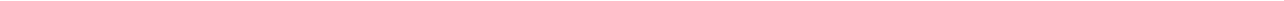
Fig. 1 Characterization of Plzf-mC/CreER transgenic mice. a , b Representative IF of adult Plzf-mC/CreER testis sections ( n = 3 mice). Tubule stages and populations are indicated. Scale bar, 50 μ m. c Representative fl ow cytometry of fi xed and permeabilized testis from Plzf-mC/CreER and wildtype (WT) adult testis ( n = 3 mice per genotype). PLZF + cells are shown. d Plzf-mC/CreER; Z/EG mice injected daily with TAM for 5 days were harvested at indicated days after treatment. e Representative IF of testis sections from d ( n = 3 testes per time point). Insets show details of indicated areas. Scale bar, 50 μ m. f Representative whole-mount IF from d . Inset shows detail of indicated area. Arrowheads: unlabelled GFR α 1 + cells. Scale bar, 50 μ m. g Flow cytometry of fi xed and permeabilized testis cells from d . Graph indicates mean fraction of A undiff (PLZF + c-KIT − ) and PLZF + c-KIT + early differentiating cells expressing GFP ± standard error of mean (s.e.m.) ( n = 4 testes D3, D10 and D90, n = 6 testes D30). h Representative fl ow cytometry of live Plzf-mC/ CreER testis cells. SSC is side scatter. mCherry + gate was set according to WT. i Quantitative RT-PCR for spermatogonial markers from Plzf-mC/CreER cell fractions sorted as in h . mC − indicates mCherry − . Expression levels are corrected to β -actin and normalized so mean value of fraction #2 equals 1. Mean values± s.e.m. are indicated ( n = 3 sorts, 2 mice pooled per sort). Signi fi cance vs. mCherry − cells is shown. j Violin plots of gene expression in 150 single cells of fraction #1 cells from h . Cells were gated according to Plzf and Vasa expression. k Left: mean in vitro colony-forming activity of Plzf-mC/ CreER fractions ± s.e.m. isolated as in h ( n = 3 mice). mC − indicates mCherry − . Signi fi cance vs. mCherry − fraction is indicated. Right: representative IF of passaged cells from fraction #1 treated with vehicle or retinoic acid for 48 h ( n = 3). Scale bar, 50 μ m. l Left: transplantation of cultured cells established from Plzf-mC/CreER fraction #1. Right: representative whole-mount IF of tubules 8 weeks post transplant demonstrating formation of mCherry + colonies ( n = 5 recipients). Comparable spermatogenic capacity was observed upon transplantation of an independent line (3.90 colonies/10 5 cells; n = 4 recipient testes). Scale bar, 100 μ m. Signi fi cance was calculated by two-tailed Student ’ s t -test (** P < 0.01, *** P < 0.001, **** P <